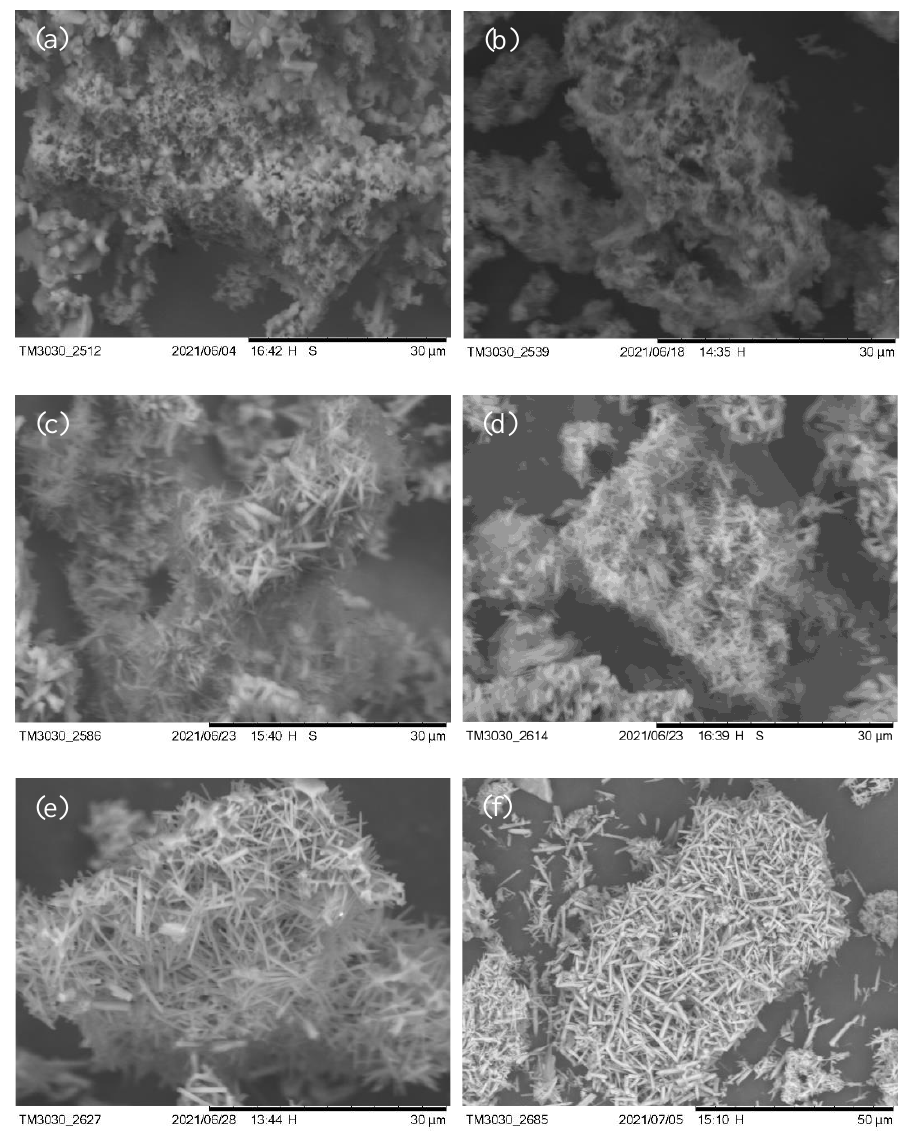
Figure 13. SEM images of mullite whiskers with different aluminum fluoride contents in 10% sodium sulfate molten salt calcined. ( a ) 0.5% AlF 3 ·3H 2 O, ( b ) 1% AlF 3 ·3H 2 O, ( c ) 2% AlF 3 ·3H 2 O, ( d ) 3%